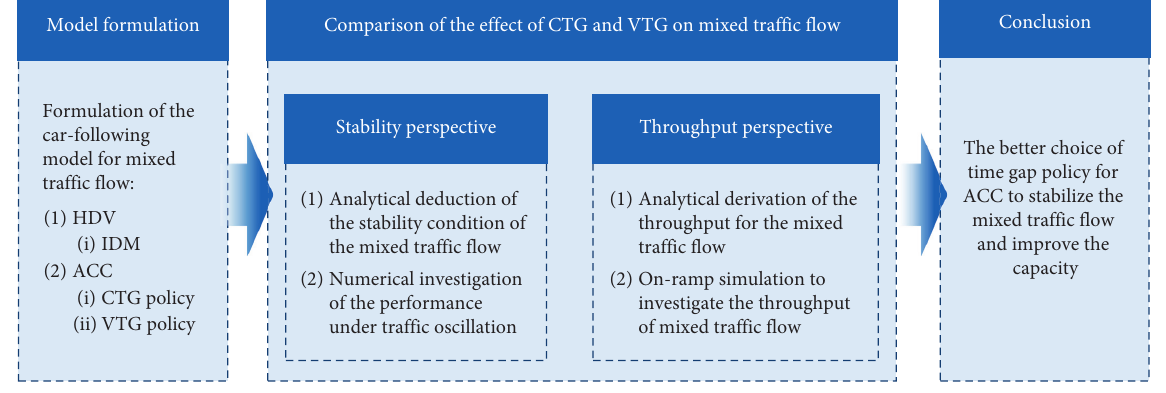
Figure 1: The structure diagram of this